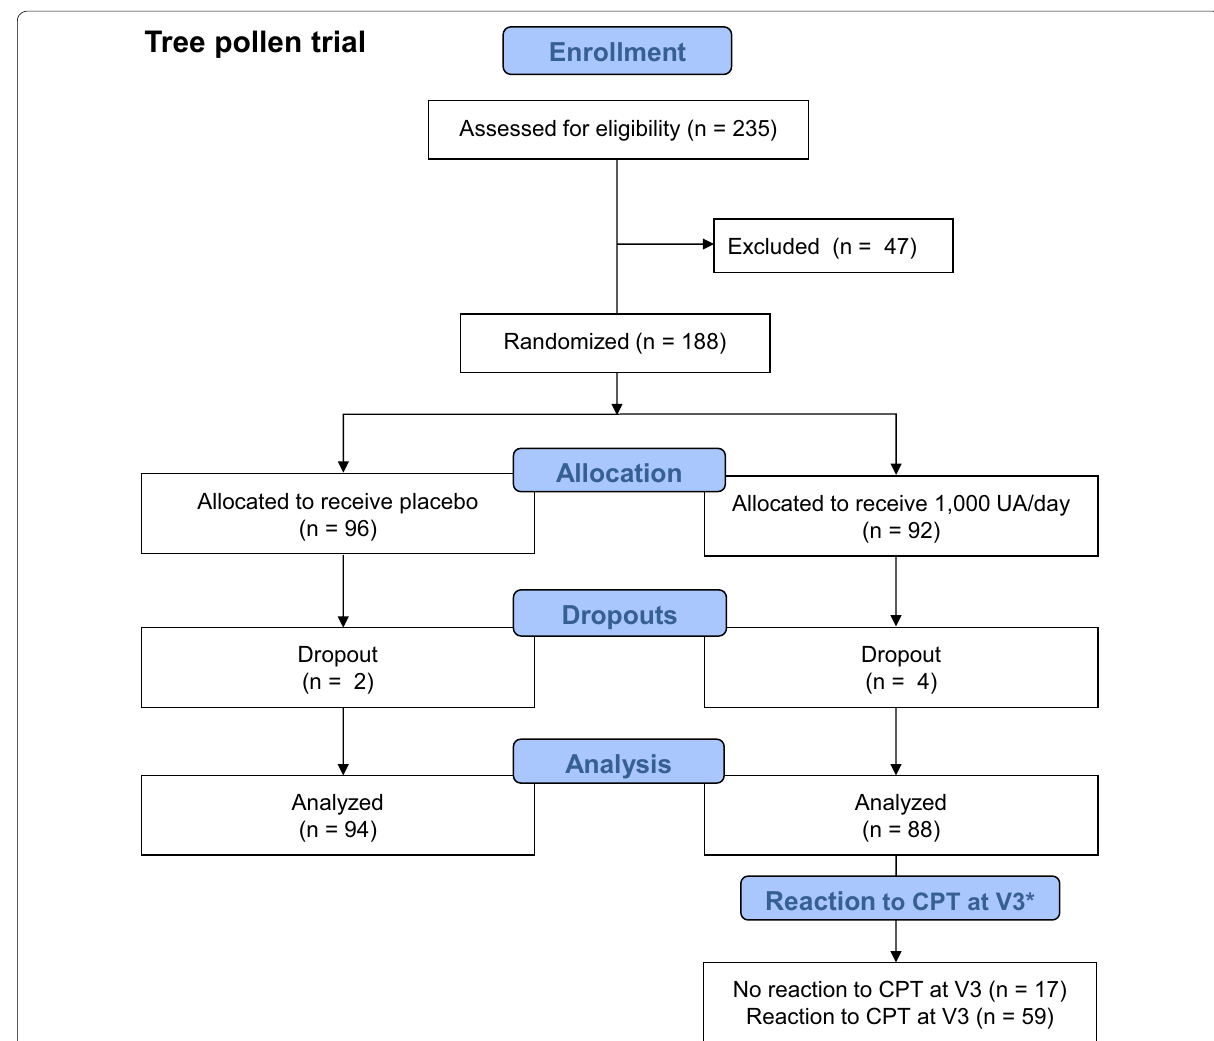
Fig. 2 Flowchart of the tree pollen study population. *Due to an unforeseen shortage of CPT allergen solution on the manufacturer’s part, the CPT at V3 was optional, depending whether sufficient allergen solution was available. CPT conjunctival provocation test, UA unit of allergen, V